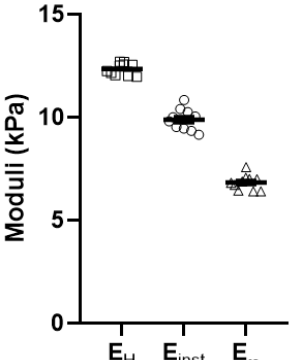
Figure A9. Comparison between the different modules obtained with microindentation ( E H ) and relaxation ( E inst and E ∞ ) for a 4 kPa PAM hydrogel immersed in a ddH 2 O + 0.1% Extran